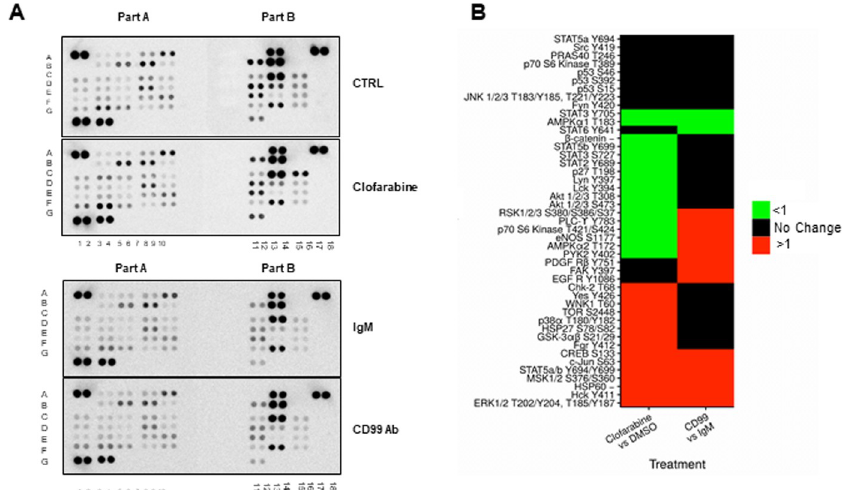
Fig 2. Phosphokinase array analysis of STA-ET.7.2 cells after treatment with clofarabine and CD99 antibody. (A) Phosphokinase screening of cells treated with clofarabine (0.6 μ M) and DMSO (upper pair) or CD99 antibody (15 μ g/ ml), and IgM (15 μ g/ml) (lower pair). Protein coordinates of the kinase array are given in S1 Fig; (B) Analysis of band intensity after treatment with clofarabine and CD99 antibody is given. Red color indicates increased phosphorylation, black color indicates no change and green color indicates decreased phosphorylation compared to control in each group. ERK1/2, MSK1/2, CREB, c-Jun, HSP60, Hck and STAT5 phosphorylation levels were increased while STAT3 and AMPK α 1 were decreased for both treatment